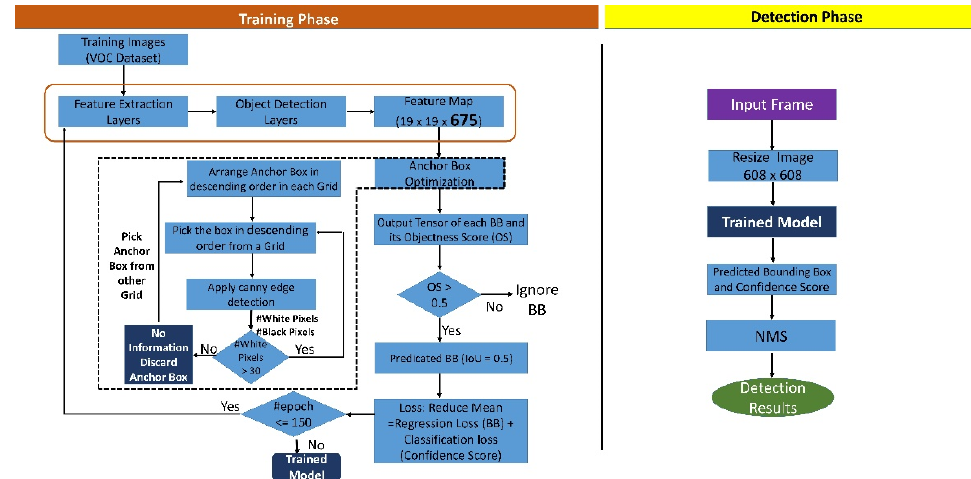
Figure 9. Efficient multi-scale anchor box (Example 2).